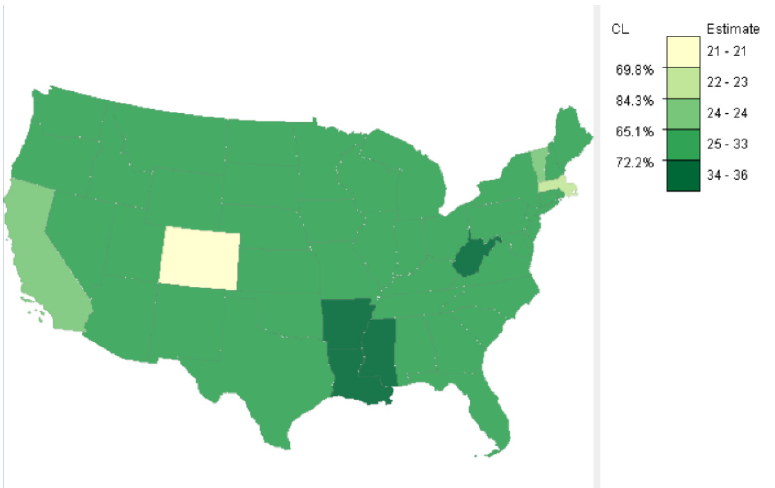
Figure 4. Five classes of adult obesity rates by states of the U.S., 2014, determined by the class separability method. Each confidence level (CL) on the left of the legend indicates the approximate probability that values above and below the corresponding class break are statistically different. The mapping tool, SEER*CMapper , is available via http://geospatial.gmu.edu (accessed on 3 June